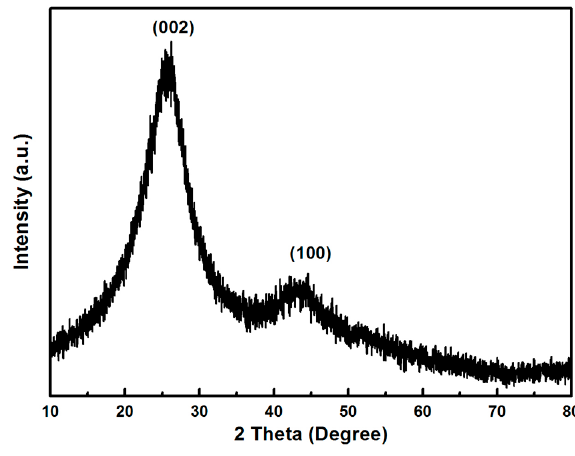
Figure 2. X-ray diffraction (XRD) patterns of thin BCN sheets.